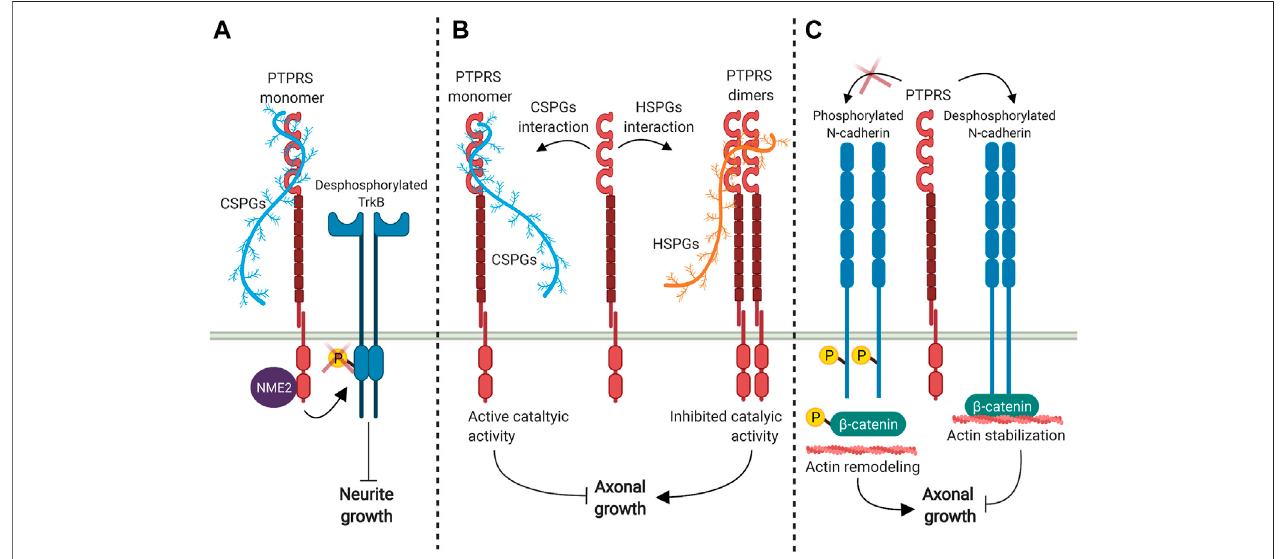
FIGURE3| PTPRS signaling modulatesdendrite and axongrowth. (A) PTPRS interactionwithCSPGs promotes TrkBdephosphorylationwhichreducesdendrite growthinamechanismthatappearstobemediatedbyPTPRS-NME2interaction(KuriharaandYamashita,2012;Lesnikovaetal.,2020). (B) PTPRS-HSPGsinteraction induce PTPRS dimer formation, which inactivates its catalytic activity and favors axon growth; while the interaction with CSPGs promotes the PTPRS monomer conformation, inducing its catalytic activity and inhibits axonal growth (Shen et al., 2009; Coles et al., 2011). (C) PTPRS interaction with N-cadherin dephosphorylates N-cadherin and β -catenin, which favors N-cadherin- β -catenin interaction, stabilizes actin cytoskeleton, and reduces axonal growth (Siu et al., 2007).